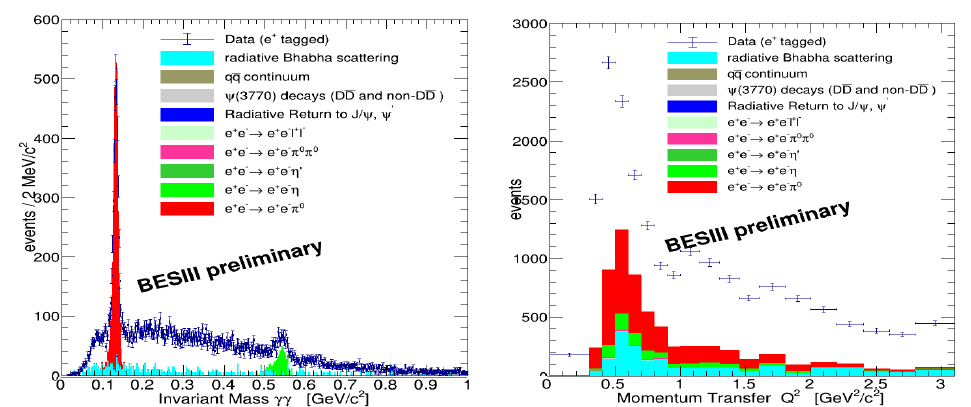
Figure 3: The γγ invariant mass distribution (left) and Q 2 distribution (right) from data and MC simulations. The dot with error bars are data, the red histogram is from signal MC simulation, other colored histograms are from background MC sim- ulations.